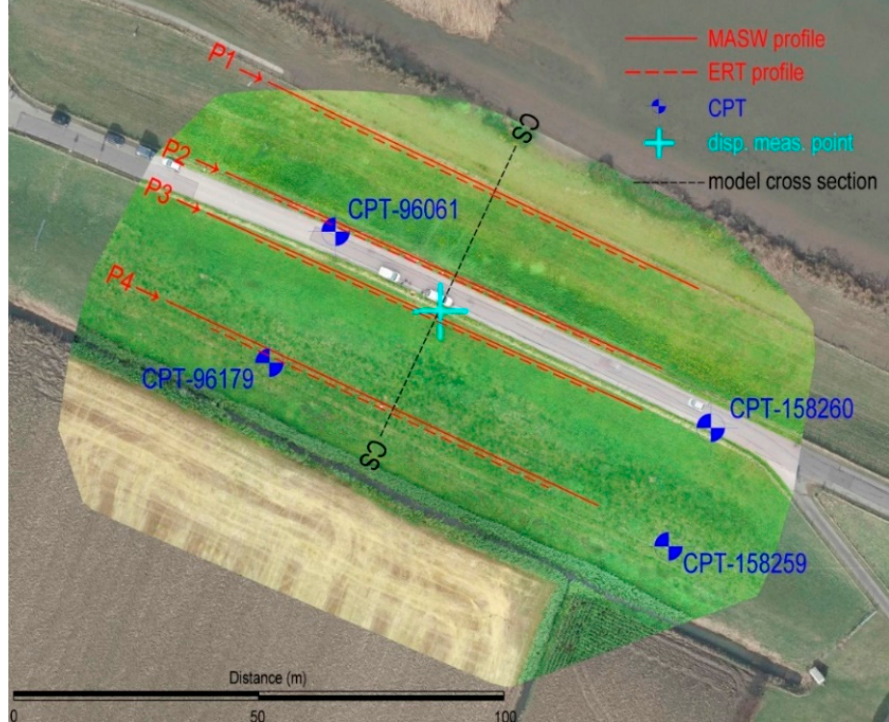
Figure 9. Layout of geotechnical and geophysical investigation work on Oostmolendijk. Table 1. Overview of the Oostmolendijk investigation methods and displacement monitoring.